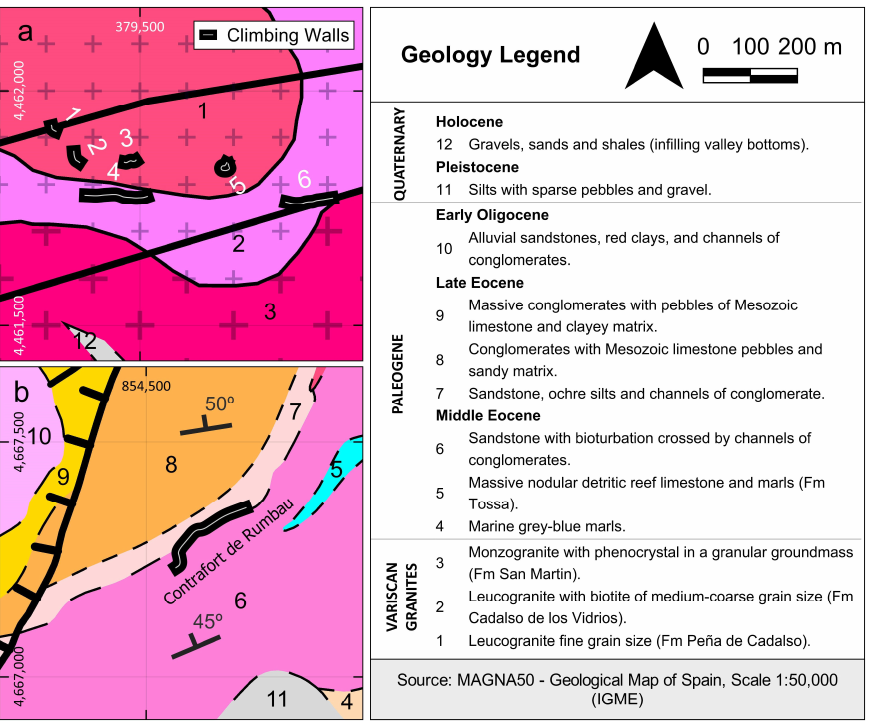
Figure 4. Geological maps of the studied sites: ( a ) Oliana; ( b ) Cadalso de los Vidrios. See text for further